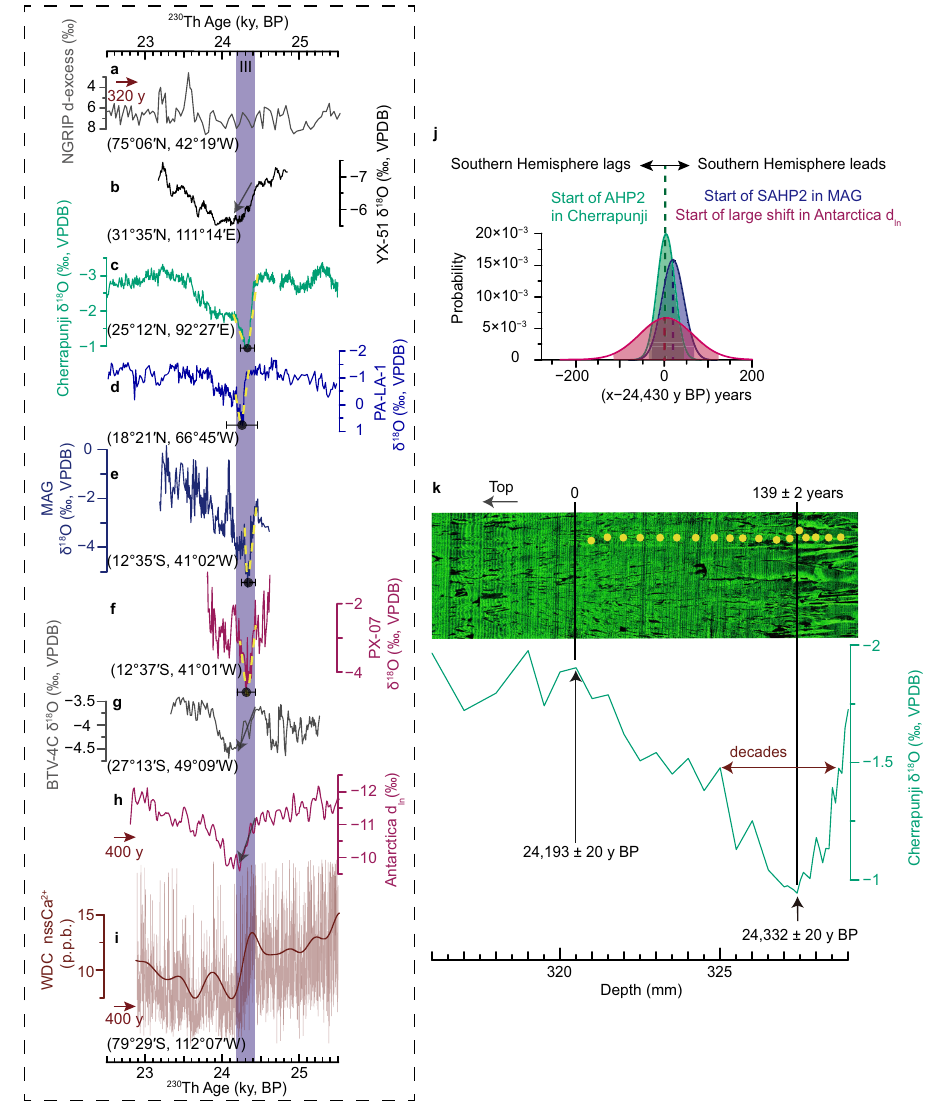
Fig.5|GlobalatmosphericteleconnectionsduringstageIII.a NGRIPdeuterium- excess record 69 on the GICC05 chronology and shifted by +320 years. b – g speleothem δ 18 O records from Yongxing Cave (YX-51, this study), Cherrapunji Cave (Cherrapunji, this study), Larga Cave (PA-LA-1 96 ), Marota Cave (MAG, this study), Paixão Cave (PX-07, this study), and Botuverá Cave (BTV-4C, this study), respectively. h Antarctica 5-core averaged d ln anomaly 16 . i Antarctica WDC ice-core non-sea-salt Ca 2+ [nssCa 2+ ] record 74 and overlain by the thick line (high-frequency variability(>1cycleper300year)removedbyalow-passButterworth fi lter,sameas in ref. 74). Antarctic ice-core records in ( h ) and ( i ) are on the WD2014 chronology and shifted by +400 years. The yellow dashed lines in ( c – f ) are generated via the BREAKFIT algorithm 45 . Black dots and associated error bars in ( c – f ) depict the timing of breakpoints and combined uncertainties (2 σ ) (Supplementary Table 2). Latitudesandlongitudesforthevariousrecordsin( a – g )and( i )areshown.Notethe